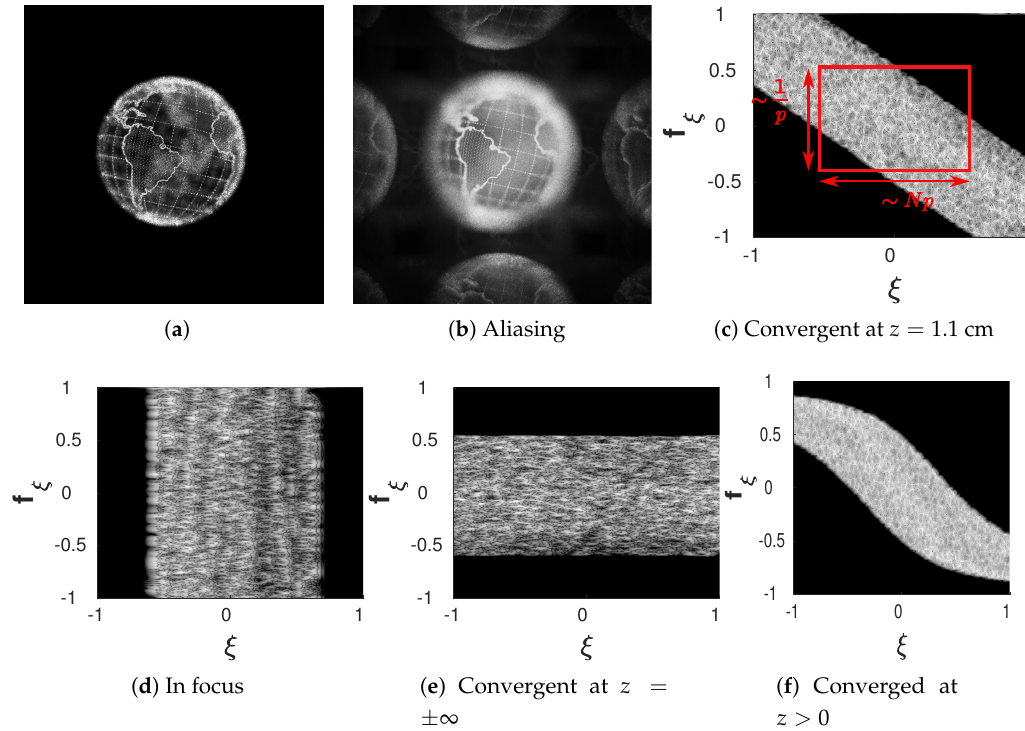
Figure 9. ( a ) Standard back-propagation of a hologram of a diffuse Earth recorded in the Fresnel limit using a numerical aperture of 1/4 of its size. ( b ) Back-propagation after undersampling the hologram by a factor of 1/0.65 without using a numerical aperture. Phase space footprints of 1D cross-sections are shown after refocusing to different distances in ( c – e ). In ( c ) the space-frequency bandwidth boundary box is marked. ( f ) Shows a hologram of the same object in a different diffraction